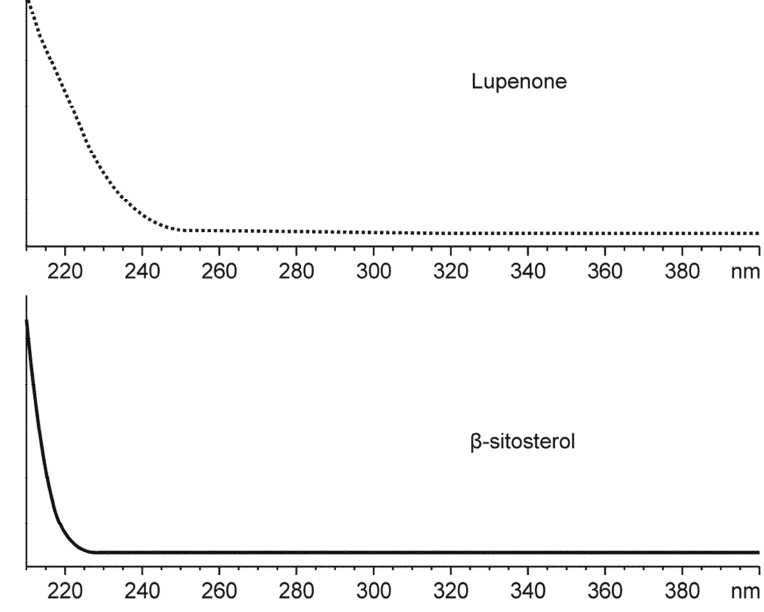
Figure 2. Ultraviolet full-band scan results of lupenone and β